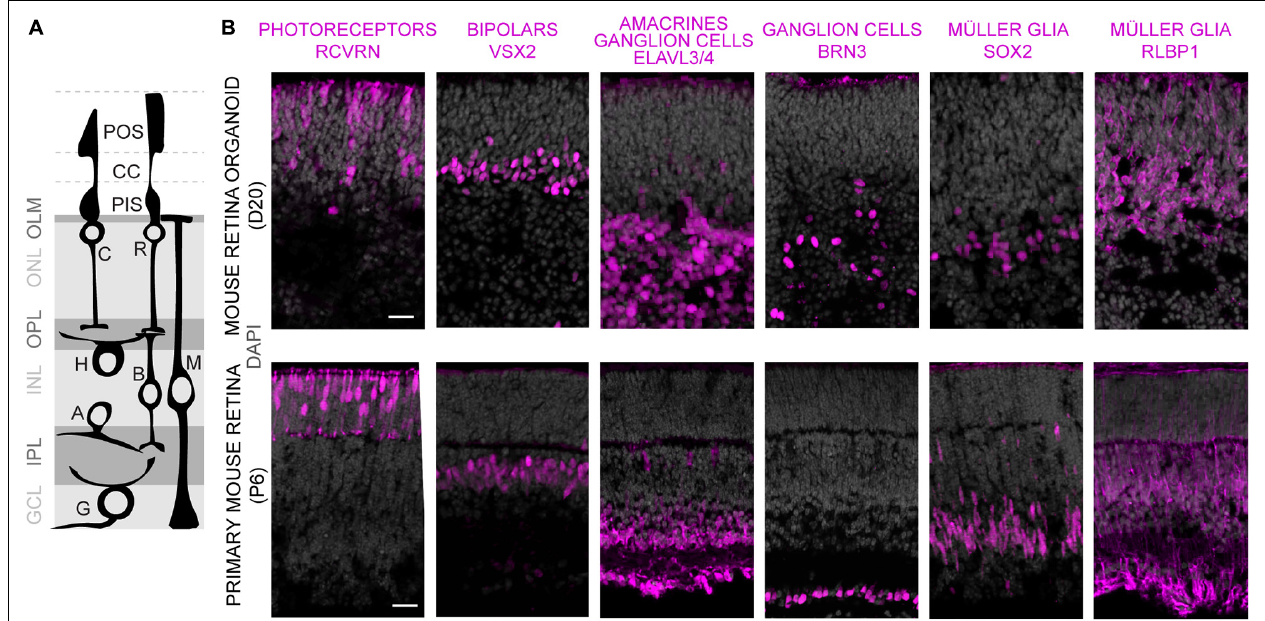
FIGURE 2 | Characterization of retinal cell composition in MROs. (A) Schematics showing major structure and cell types of the vertebrate retina. Photoreceptors: C, cone; R, rod. Interneurons: B, bipolars; A, amacrines; H, horizontals; G, ganglion cells. MG, Müller glia. Photoreceptor cell structures: CC, connecting cilium; PIS, photoreceptor inner segment; POS, photoreceptor outer segment; OLM, outer limiting membrane. Retinal layers: ONL/INL, outer/inner nuclear layers; GCL, ganglion cell layer; OPL/IPL, outer/inner plexiform layers. (B) Comparison of MRO at day (D) 20 with primary mouse retina from postnatal day (P) 6 by immunostaining analysis of cryosections using established markers. Scale bars: 25 µ